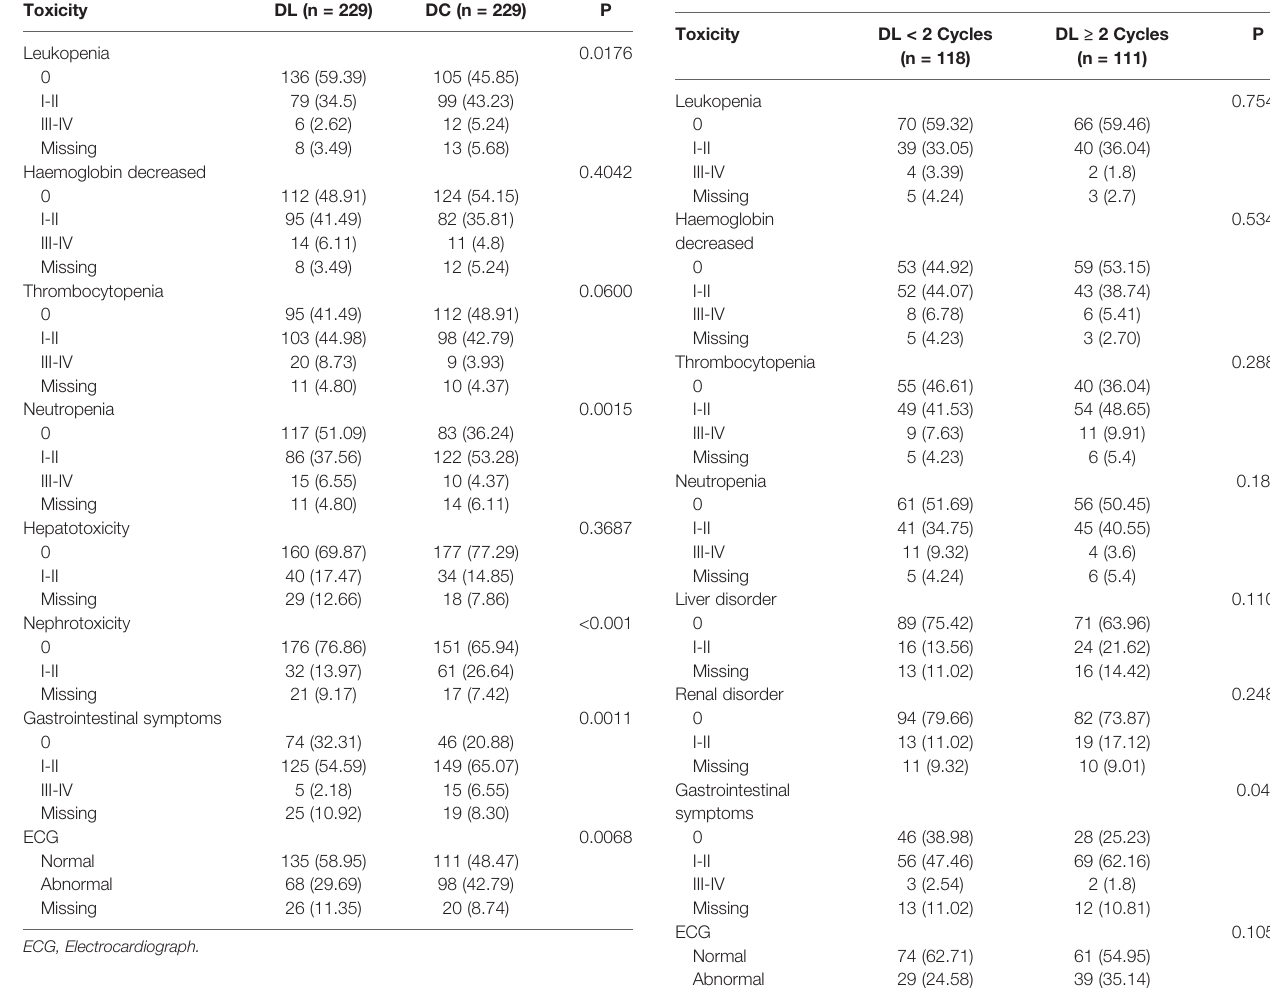
TABLE 3 | Subgroup analysis of side effects of adjuvant therapy (DL ≥ 2 cycles versus DL < 2 cycles). Toxicity DL < 2 Cycles (n =